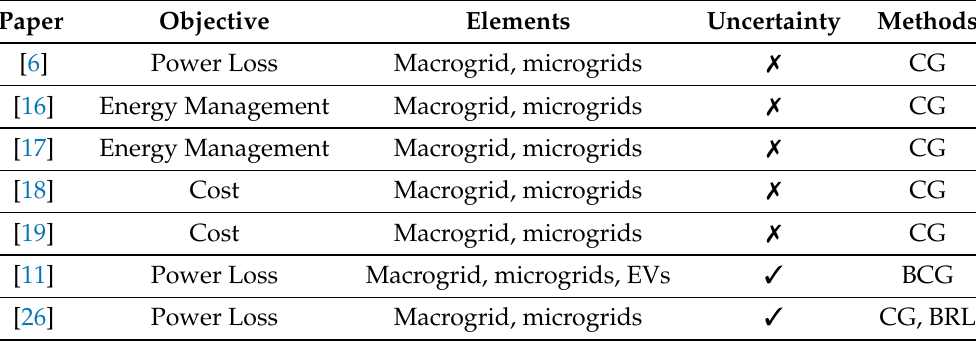
Table 1. A sumary of energy trading